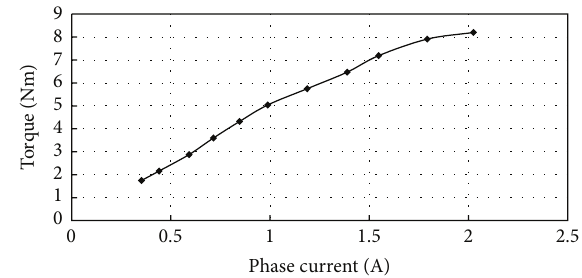
Figure 15: Measured torque versus current at the speed of 400rpm.